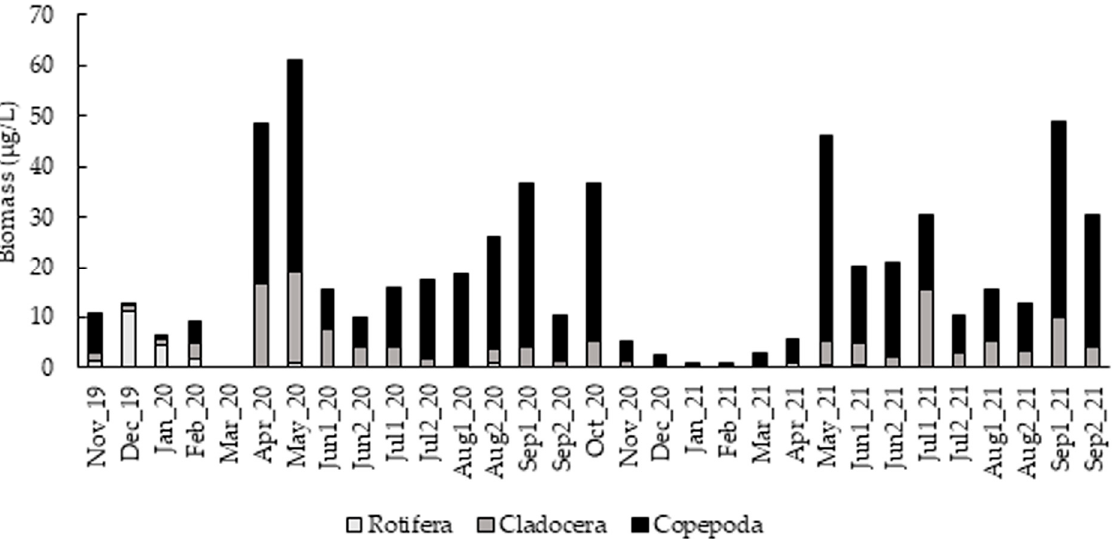
Figure 6. Total zooplankton biomass ( μ g/L) in the Moglicë Reservoir during November 2019–Sep- tember 2021. September